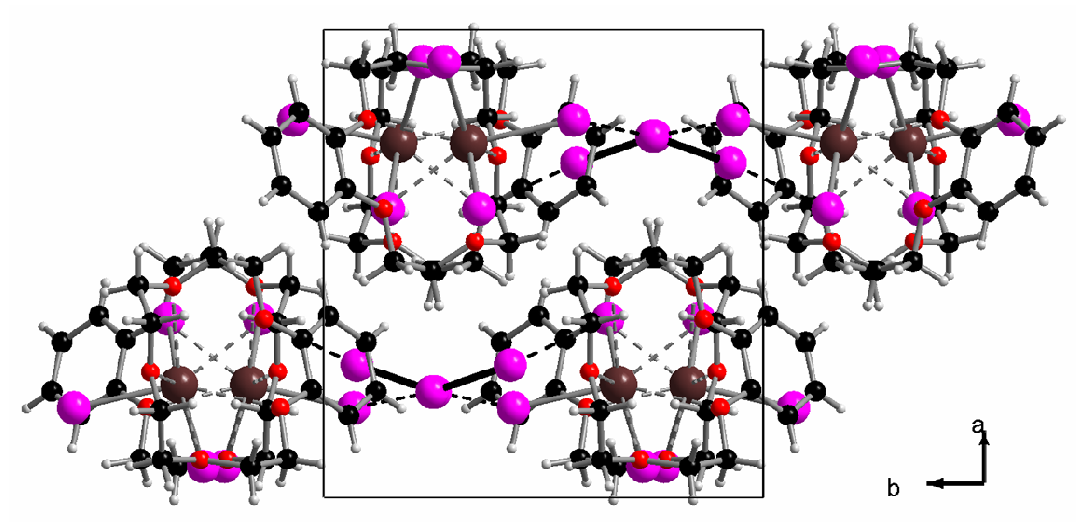
(I ) stacked parallel to 3 2